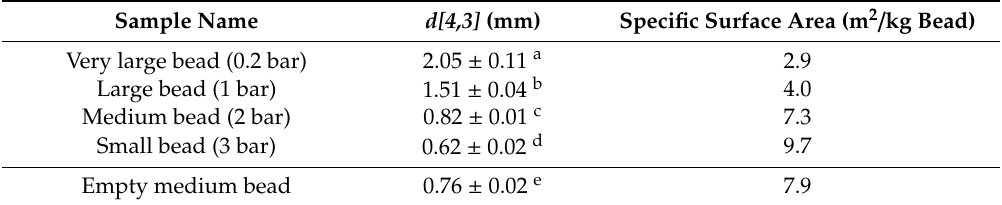
Table 1. Average diameter ( d[4,3] ) and specific surface area of iron-loaded alginate beads produced with various air pressures. Reported values are the average ± standard deviation of 20 measurements performed for two independently prepared